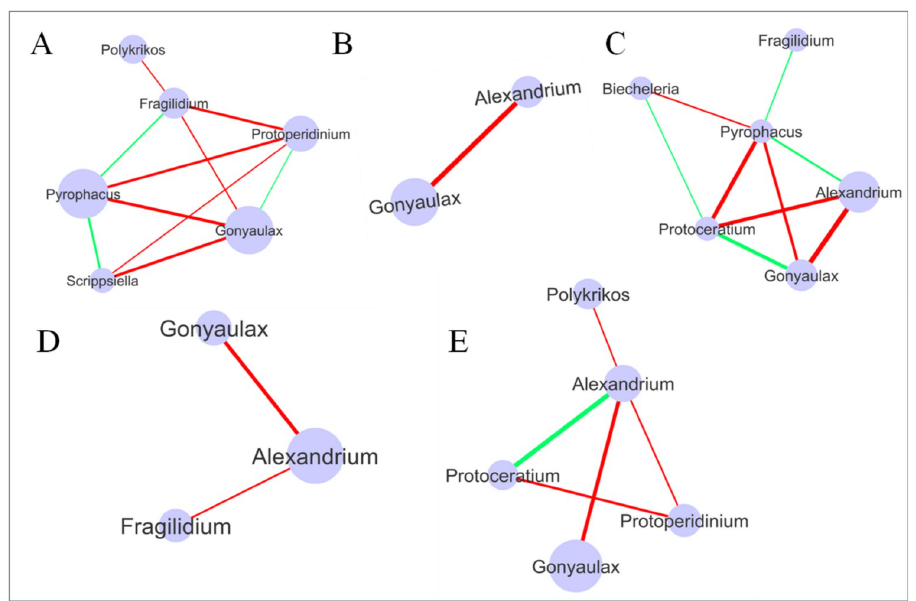
Fig 10. Network analysis of Dinoflagellata genera in stations with varying anthropogenic activity levels and during different seasons. A: Low pollution; B: Moderate pollution; C: High pollution; D: Summer; E: Winter. Node size represents overall relative abundance. The green color line represents co-presence (positive correlation) and the red color line represents mutual exclusion (negative correlation) between the taxa. The line thickness represents the correlation coefficient (a higher correlation coefficient is represented by a thicker